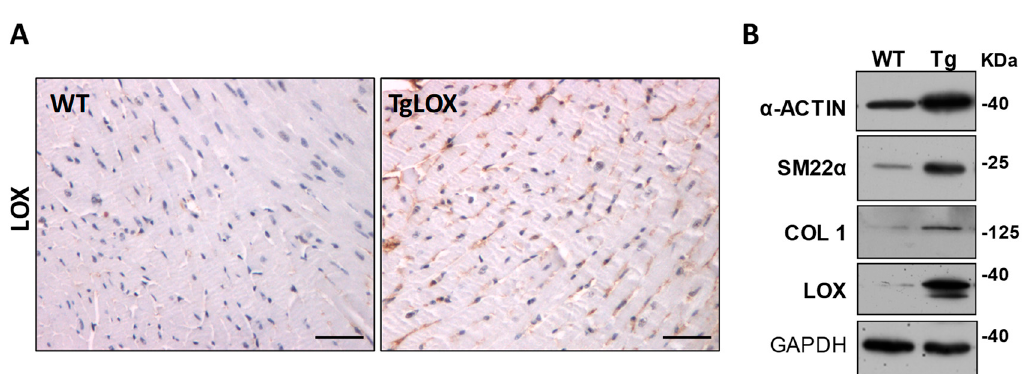
Figure 4. Impact of LOX transgenesis on cardiac fibroblast phenotype. ( A ) LOX immunohistochemical analysis in heart sections from WT and TgLOX mice evidences the increased cardiac LOX expression in LOX transgenic mice. Bar: 50 µm. ( B ) In cardiac fibroblasts from TgLOX mice, which exhibits higher LOX expression than WT cells, the expression of markers of the phenotypic switch of fibroblasts to myofibroblasts ( α -actin and transgelin; SM22 α ), as well as that of type I collagen, were increased. Representative images of Western-blot assays are shown. Glyceraldehyde 3-phosphate dehydrogenase (GAPDH) protein levels were analyzed as loading control in Western-blot assays. The position of the molecular weight standards (HyperPAGE prestained protein markers, BIOLINE; Ref: BIO-33065) is indicated.